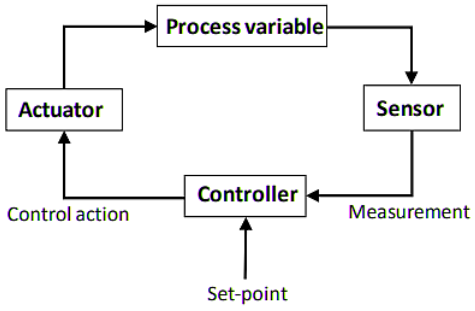
Figure 9. Data flow in a RTC control loop (source: based on Ly [78]).